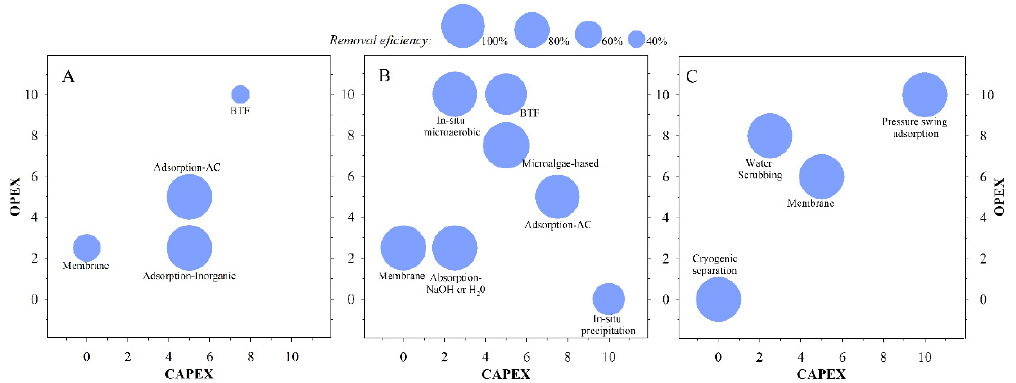
Figure 4. Evaluation of the technologies suggested by the BiogasApp_EDSS for ( A ) siloxanes removal; ( B ) H 2 S removal; and C ) CH 4 enrichment, regarding removal efficiency, CAPEX, and OPEX.